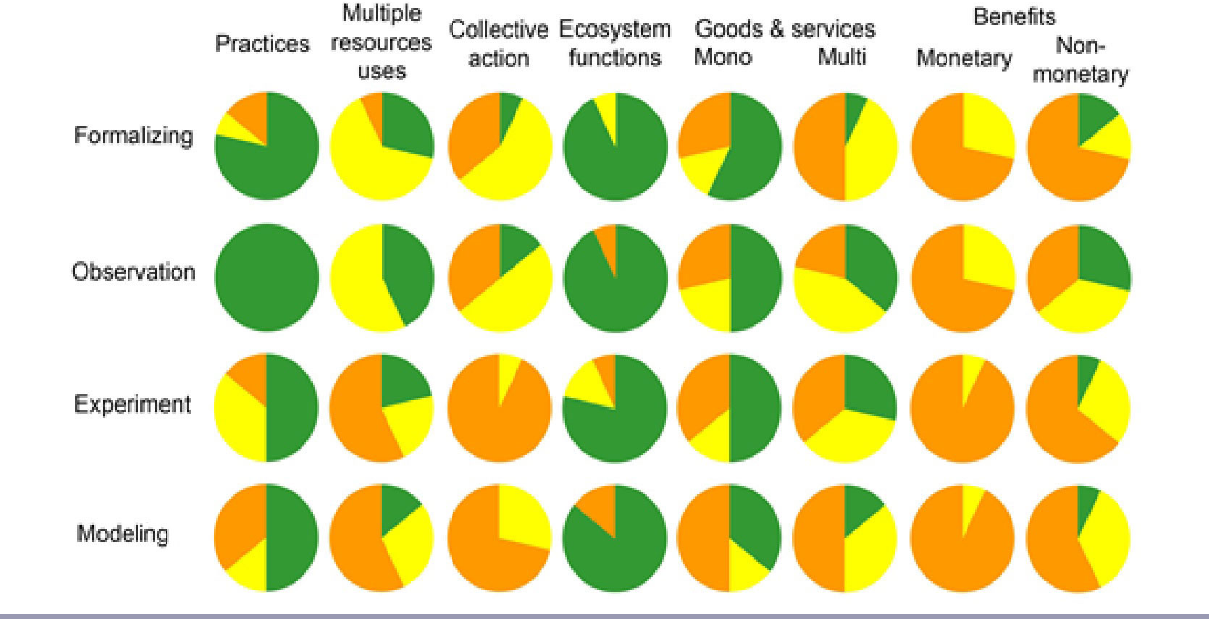
Fig. 2 . Current research investment of the 14 research platforms of the French long-term social-ecological research network for each core coupling element of the two interfaces. Several research approaches are used: formalism, observation, experimentation, and modeling. The colors indicate the levels of investment (green = high, yellow = medium, and orange = low) of each platform, i.e., 14 color rectangles per table cell. The resulting color mosaic per cell gives an overview of the current research strength and needs of the network. Goods and ecosystem services are split into mono- or multiecosystem services. Monetary and nonmonetary valuations of benefits are